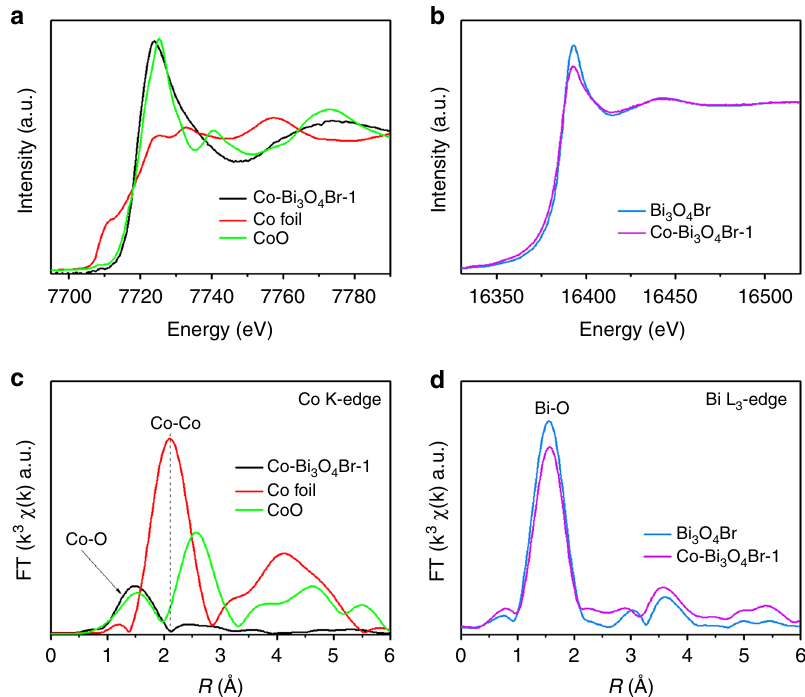
Fig. 2 Synchrotron radiation XAFS measurements. a Co K-edge XANES spectra, b Bi L 3 -edge XANES spectra, EXAFS spectra of c Co K-edge and d Bi L 3 -